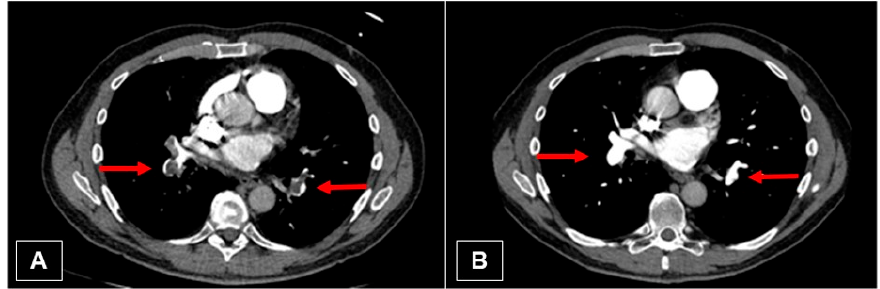
Figure 10. ( A ) Initial CT image with embolism of the right and left lower pulmonary artery (red arrows). ( B ) Nearly complete resolving of the thrombus (red